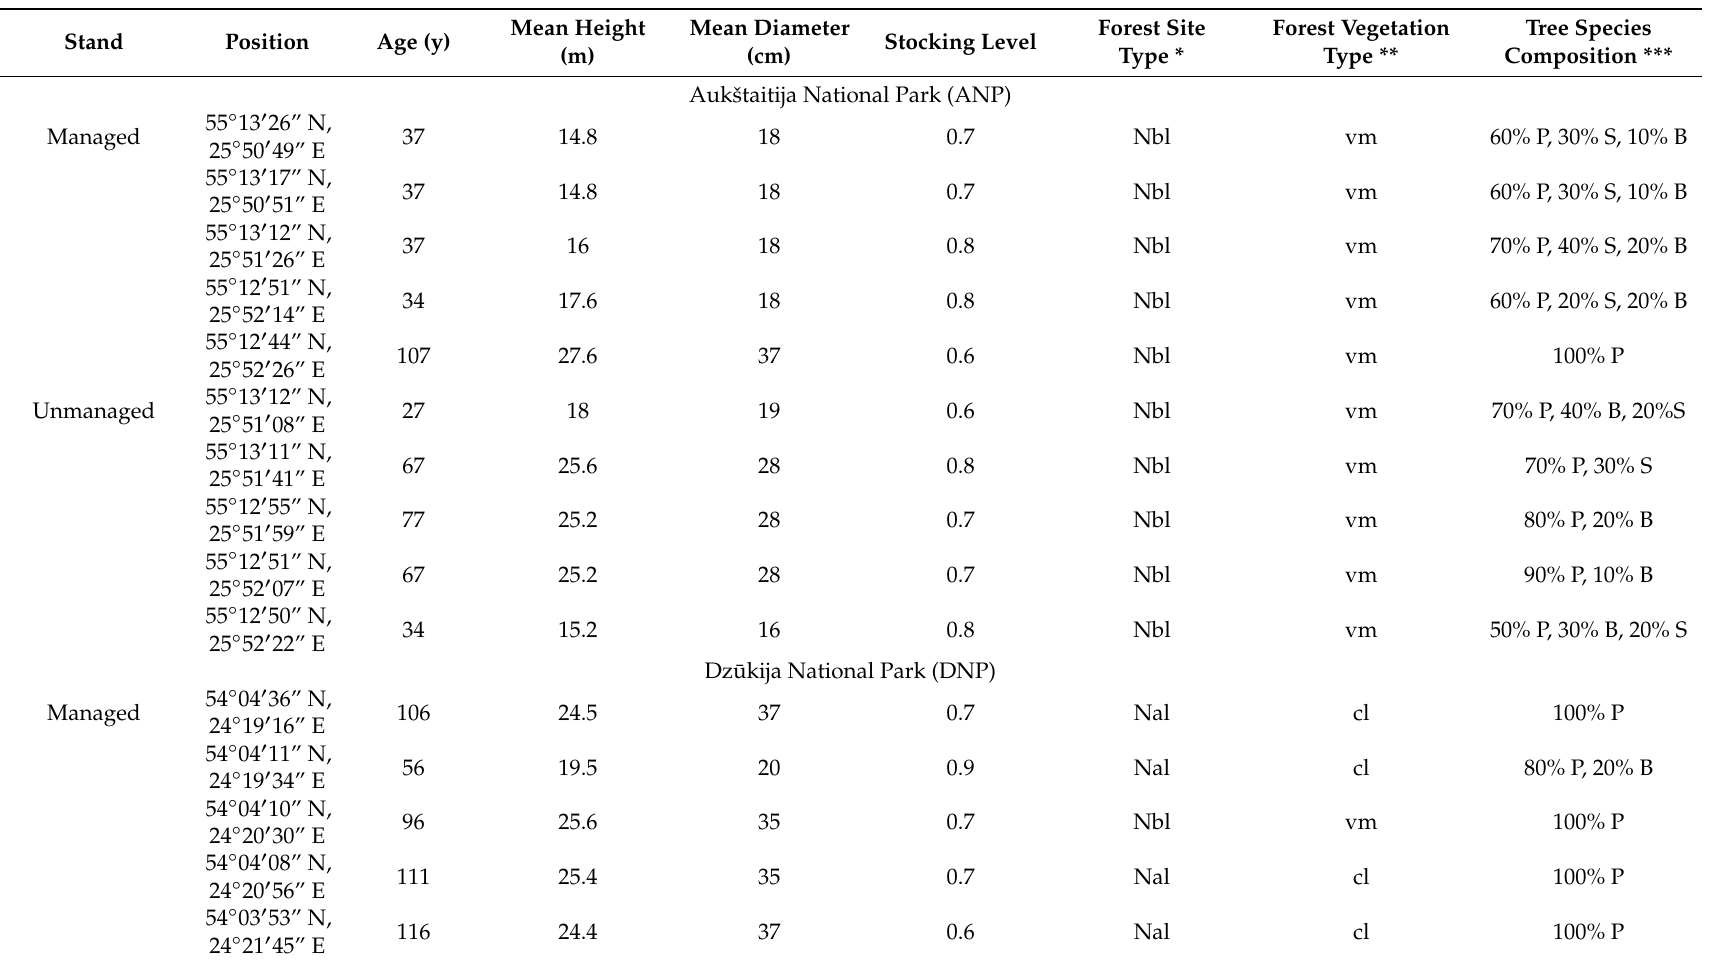
Table 1. Characteristics of investigated Pinus sylvestris stands. Information is based on the forest inventory